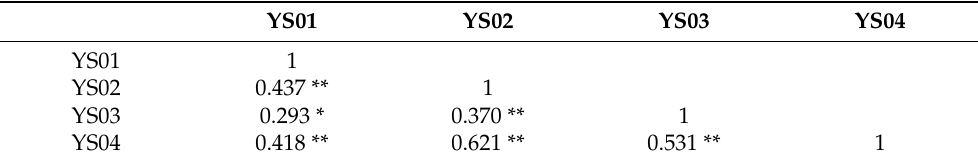
Table 2. Correlations among four residual chronologies from